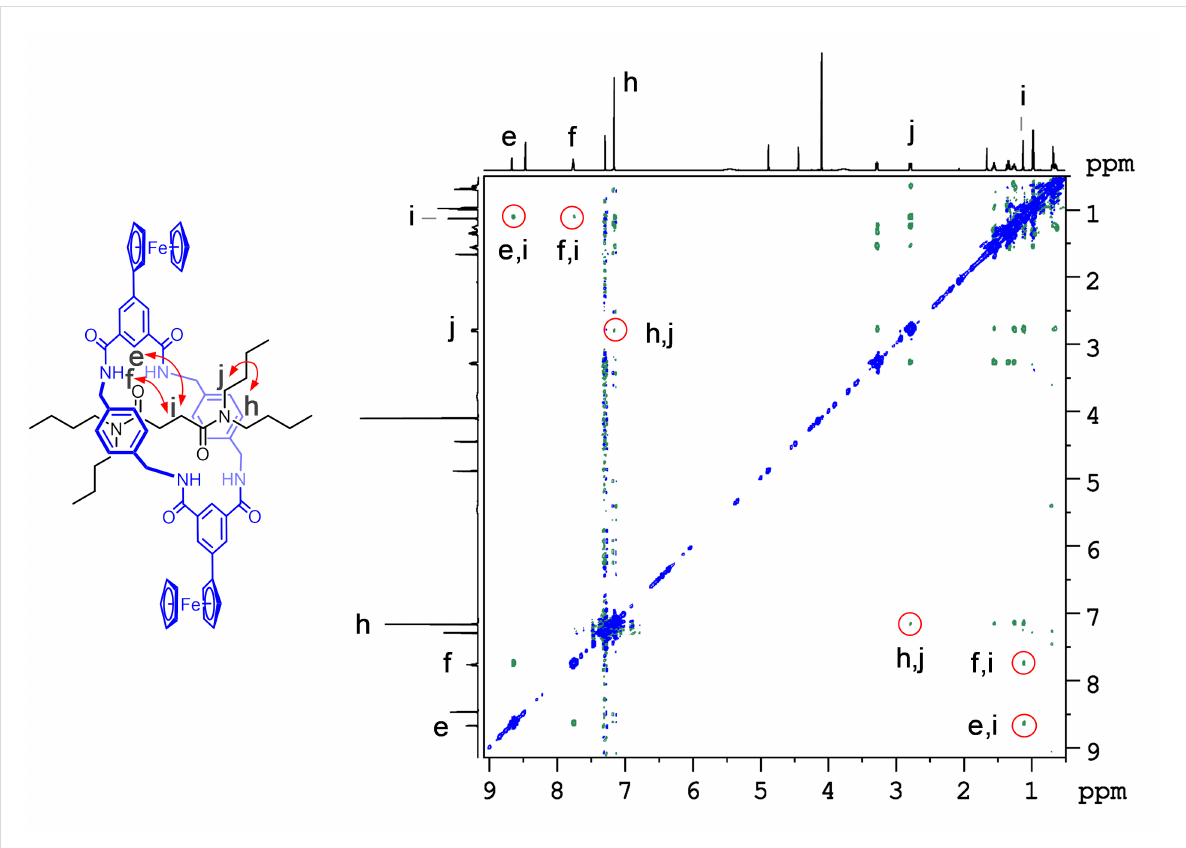
Figure 5: 1 H, 1 H-ROESY NMR spectrum (600 MHz) of the rotaxane 1a in CDCl 3 .